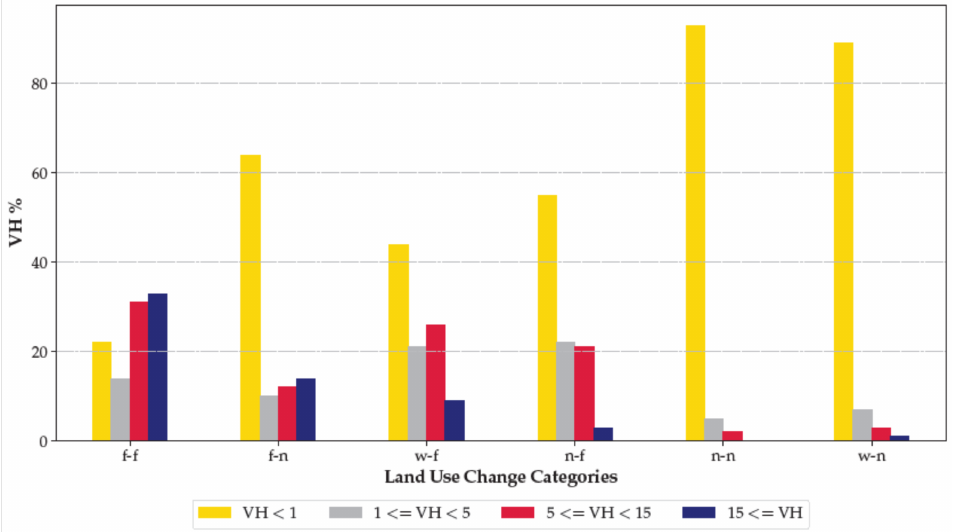
Figure 5. Distribution of VH classes in land cover change categories.